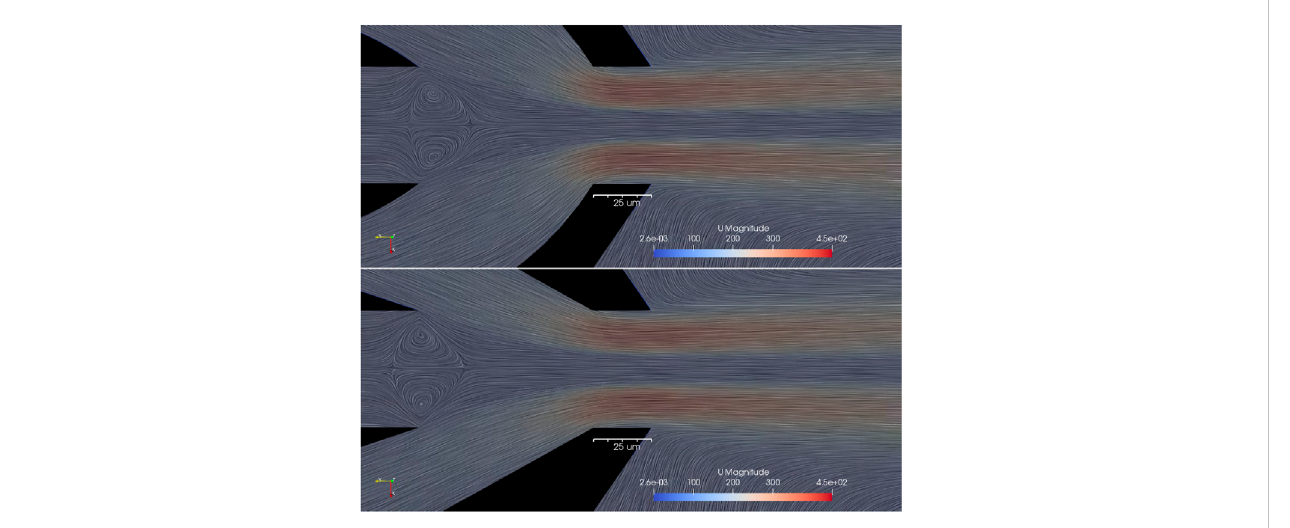
FIGURE 20 Pressurescalar fi eldinpascalsforthegasandliquidforthe3Dsimulationofthecone-shapedandbell-shapednozzles.Thepressuredropfrominsidethe nozzle and outside is responsible for the gas acceleration at the ori fi ce. The pressure jump inside the liquid jet occurs as a result of surface tension.